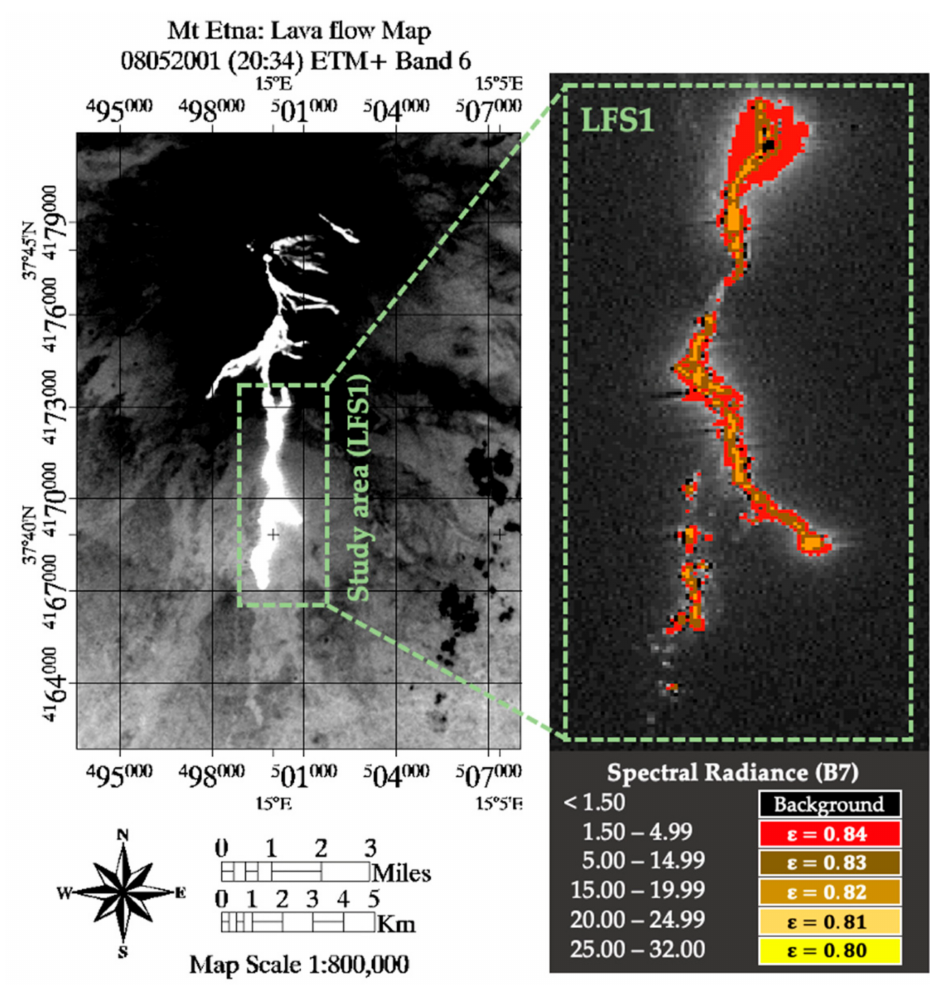
Figure 8. ( left ) Study area (LFS1) [7] indicated on ETM+ TIR (Band 6) image, used here for visual presentation purposes alone; ( right ) ETM+ scene, Band 7, acquired on 5 August 2001, showing all radiant pixels, within the high-temperature thermal anomaly, used for computation of radiant heat flux in this study (both SWIR Bands 5 and 7), using a multicomponent emissivity approach. The spectral radiance (W m − 2 sr − 1 µ m − 1 ) ‘thresholding’ values used are shown in the table below the inset on the right. Table 2. Emissivity in SWIR Bands at a range of temperatures (773–1373 K). Temperature